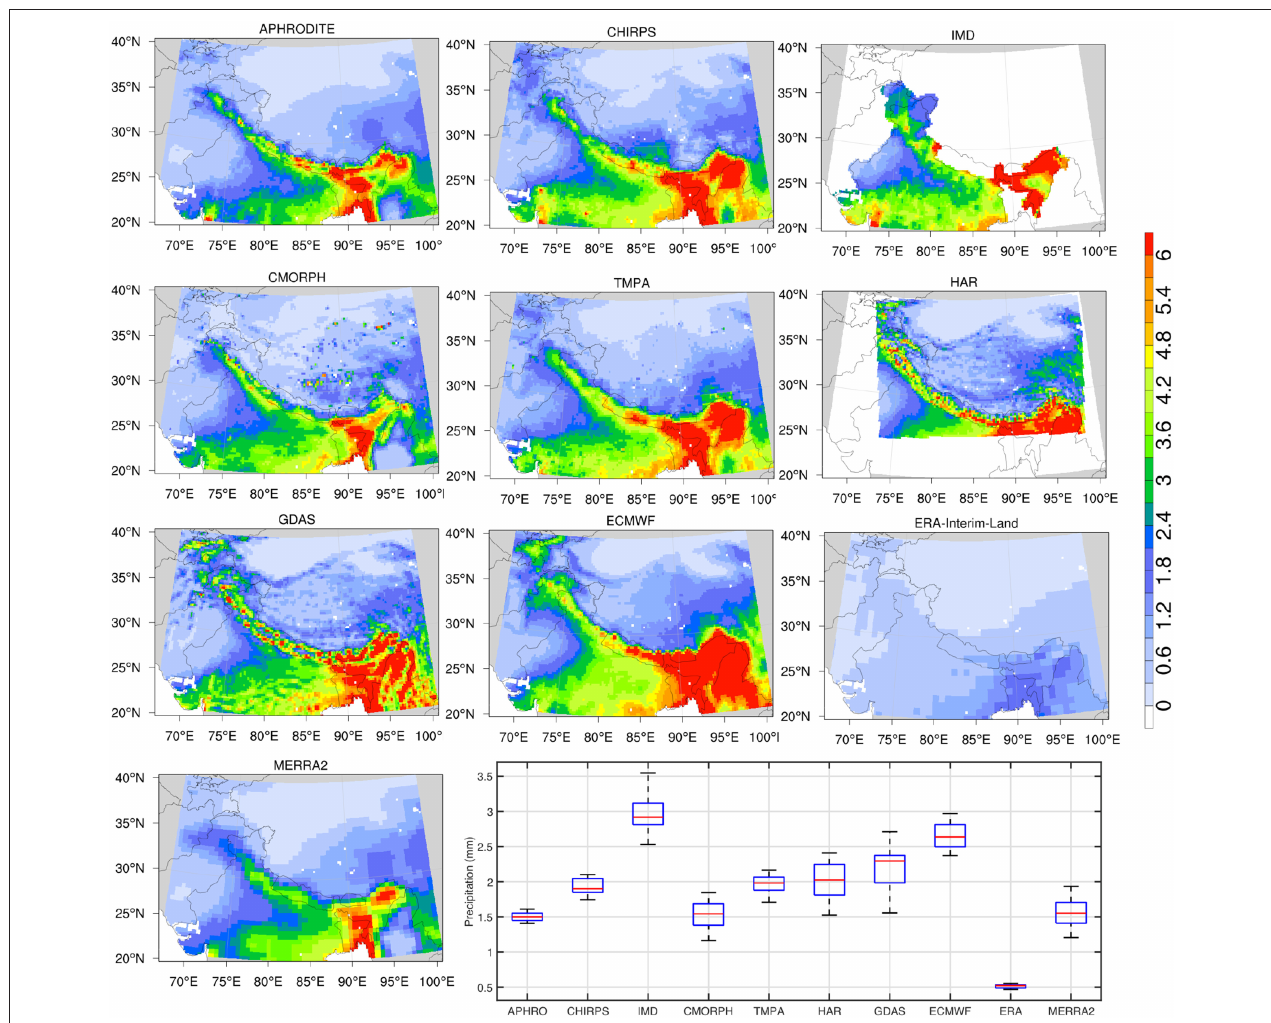
FIGURE 2 | Spatial maps of multi-annual mean precipitation (mm) and their distribution from 10 precipitation datasets ( Table 1 ). The box plot in the lower-right illustrates the median (red line), upper- and lower-quantiles (blue box) and the 25- and 75-th percentiles (black whiskers) of the multi-annual mean precipitation. Note that the IMD and HAR datasets are only available over part of the entire domain of